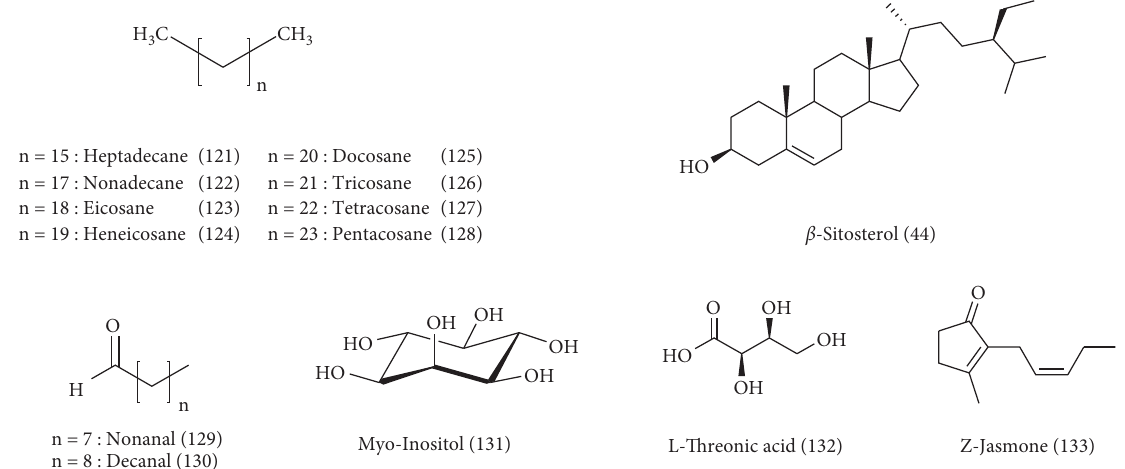
Figure 7: Structure of other compounds detected in C.